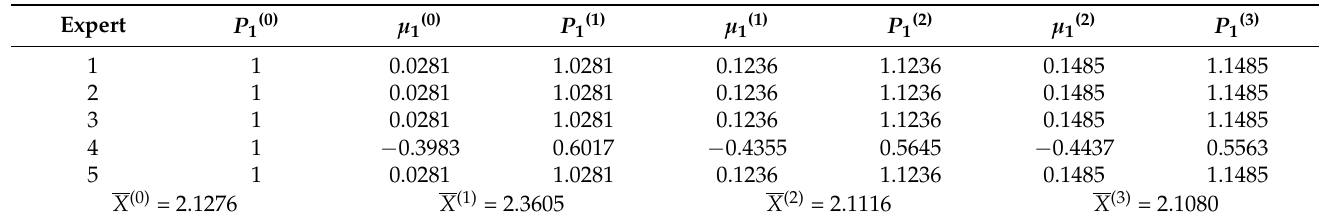
Table 9. Correction of large deformation of surrounding